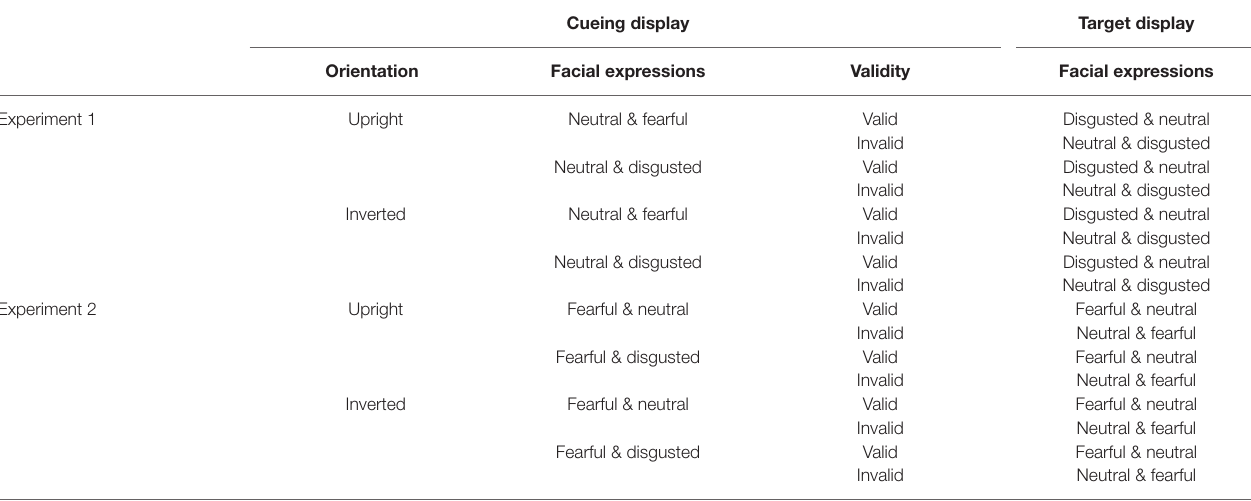
TABLE 1 | Experimental design of Experiments 1 and 2.